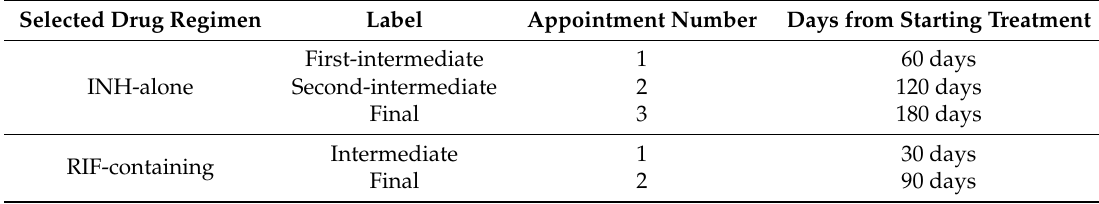
Table 1. Schedule for clinic appointments to monitor latent TB infection (LTBI) treatment follow-up. Selected Drug